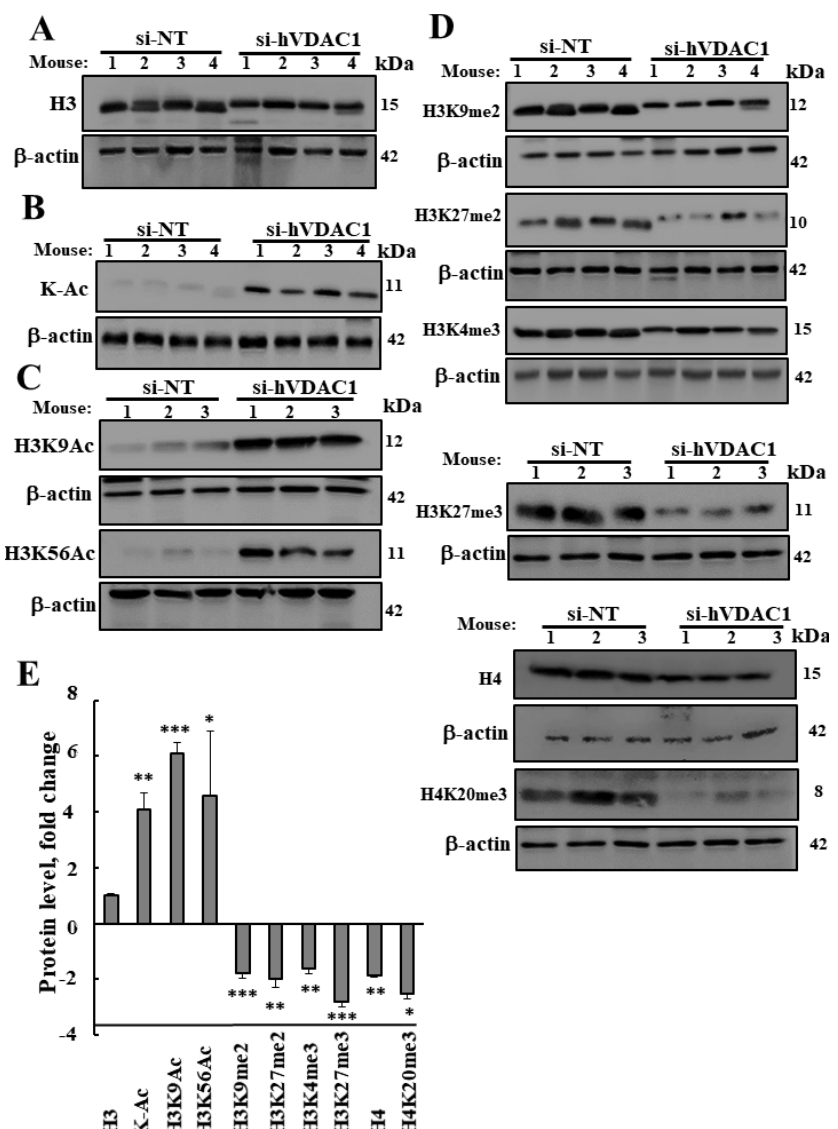
Figure 4. VDAC1 depletion reprograms epigenetics-related modifications. Proteins were isolated from si-NT-TTs and si-hVDAC1-TTs in the presence of deacetylation inhibitors as described in Materials and Methods. Immunoblots of histone 3 (H3) (A) , and of acetylated histones (K-Ac) (B) and of H3K9 and H3K56 (C) using specific antibodies are shown. β-actin served as an internal loading control. (D) Di-methylation at H3K9 (H3K9me2) and H3K27 (H3K27me2) and tri-methylation at H4K3 (H3K4me3), H3K27 (H3K27me3), and H4K20 (H4K20me3). (E) Quantification of the blots shown in (A-D). Results show means ± SEM ( n = 3). p < 0.001 (***), p < 0.01 (**), p < 0.05 (*).